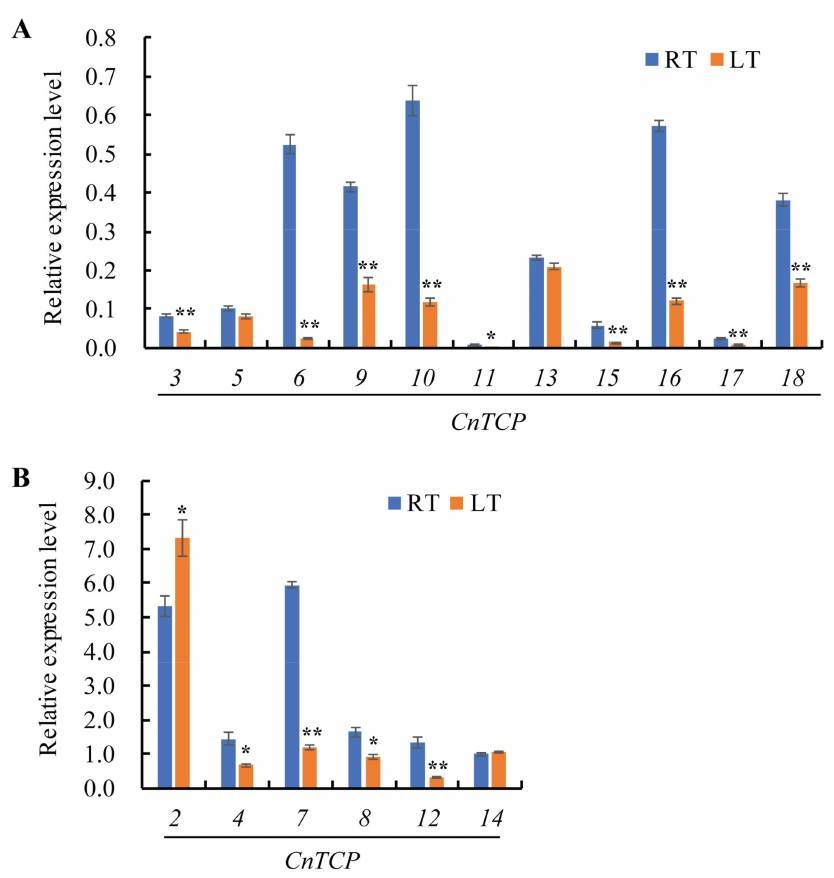
Figure 5. qRT-PCR analysis of CnTCP gene expression under cold stress. ( A , B ) Expression pattern of the CnTCP genes after a 7-day low temperature (4 ◦ C, LT) treatment. The expression level of CnTCP14 at 22 ◦ C room temperature (RT) was set at 1.0 due to its medium expression level, which could better show the expression pattern of TCP family genes. The EF-1 α gene was used as an internal control. For readability, CnTCPs with lower expression levels are included in panel A, while the ones with higher expression levels are included in panel B. One and two asterisks represent significant difference at p < 0.05 and p < 0.01, respectively, according to the paired-samples t